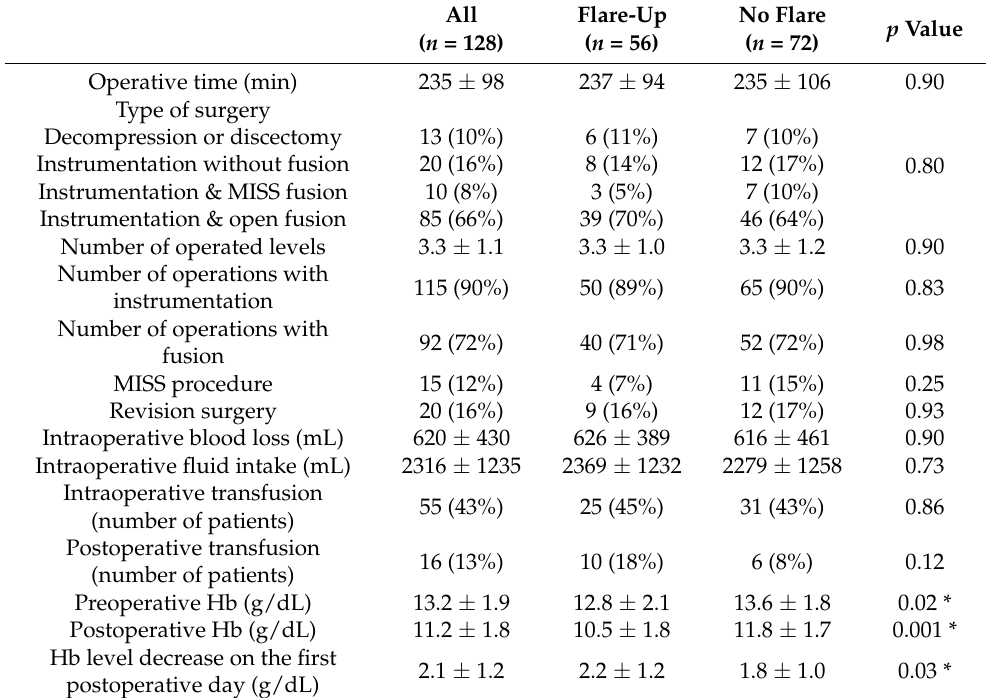
Table 2. Operative and Perioperative factors of patients.